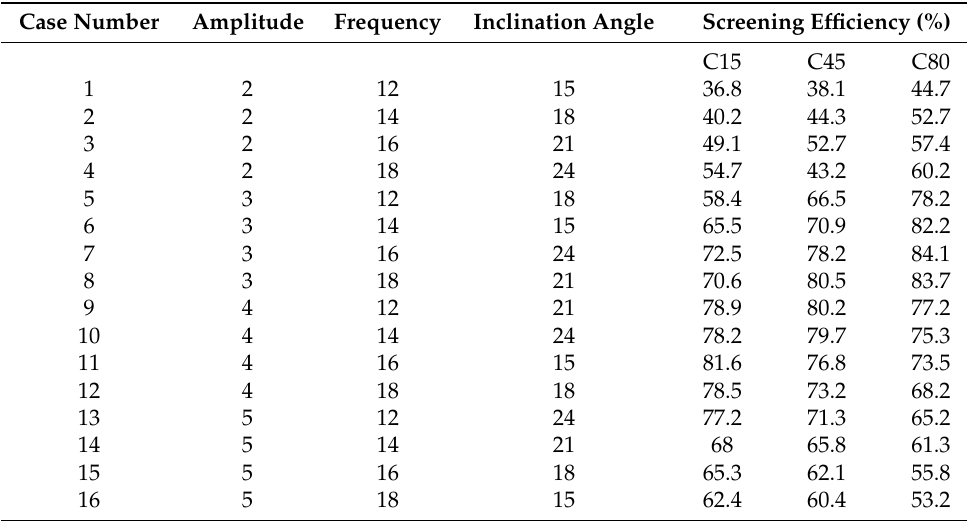
Table 4. The orthogonal test date for concrete particles